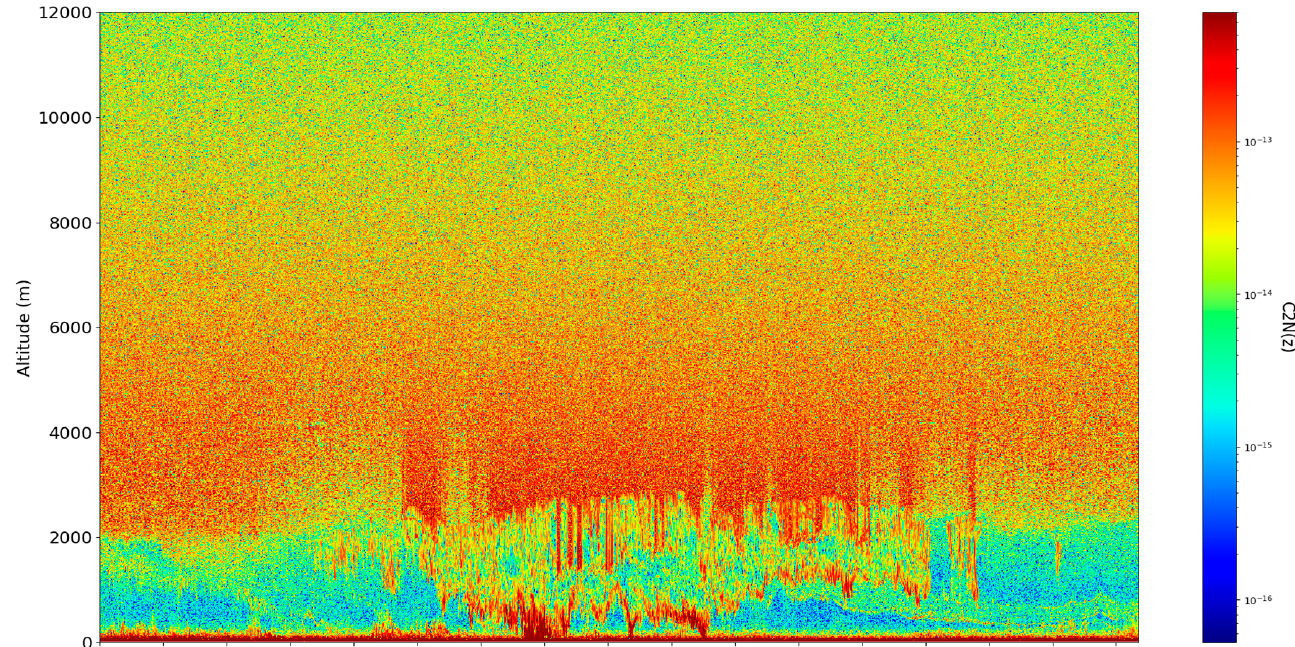
2 time series, λ = 1064 nm, Galat N